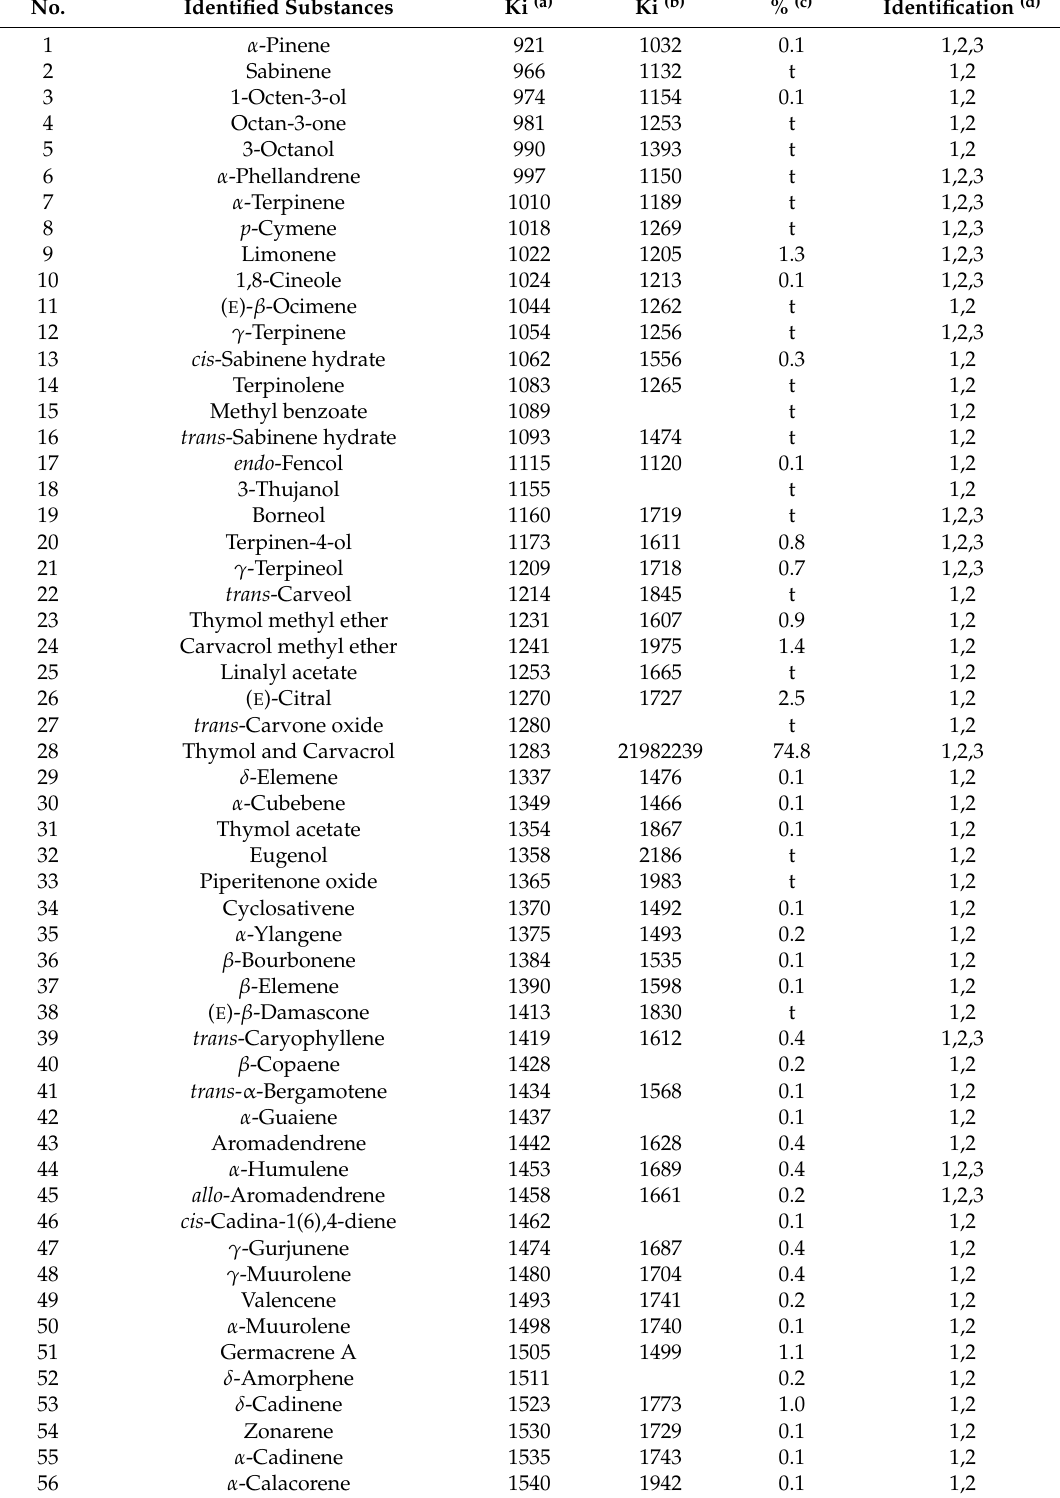
Table 1. Chemical composition of the essential oil of O. vulgare